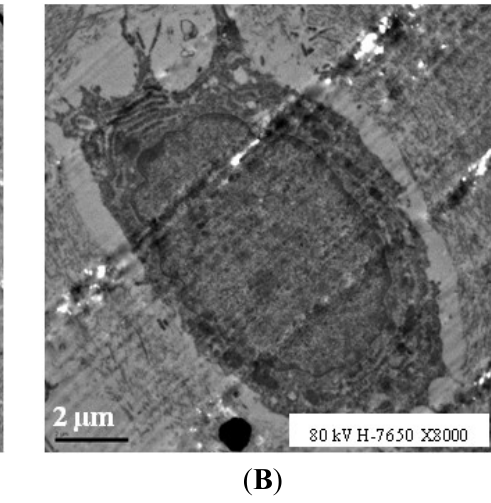
Figure 5. Transmission electron microscopy (TEM) findings of chondrocytes in proximal tibia articular cartilage. ( A – E) , samples from 1, 3, 6, 9, 12 months old group